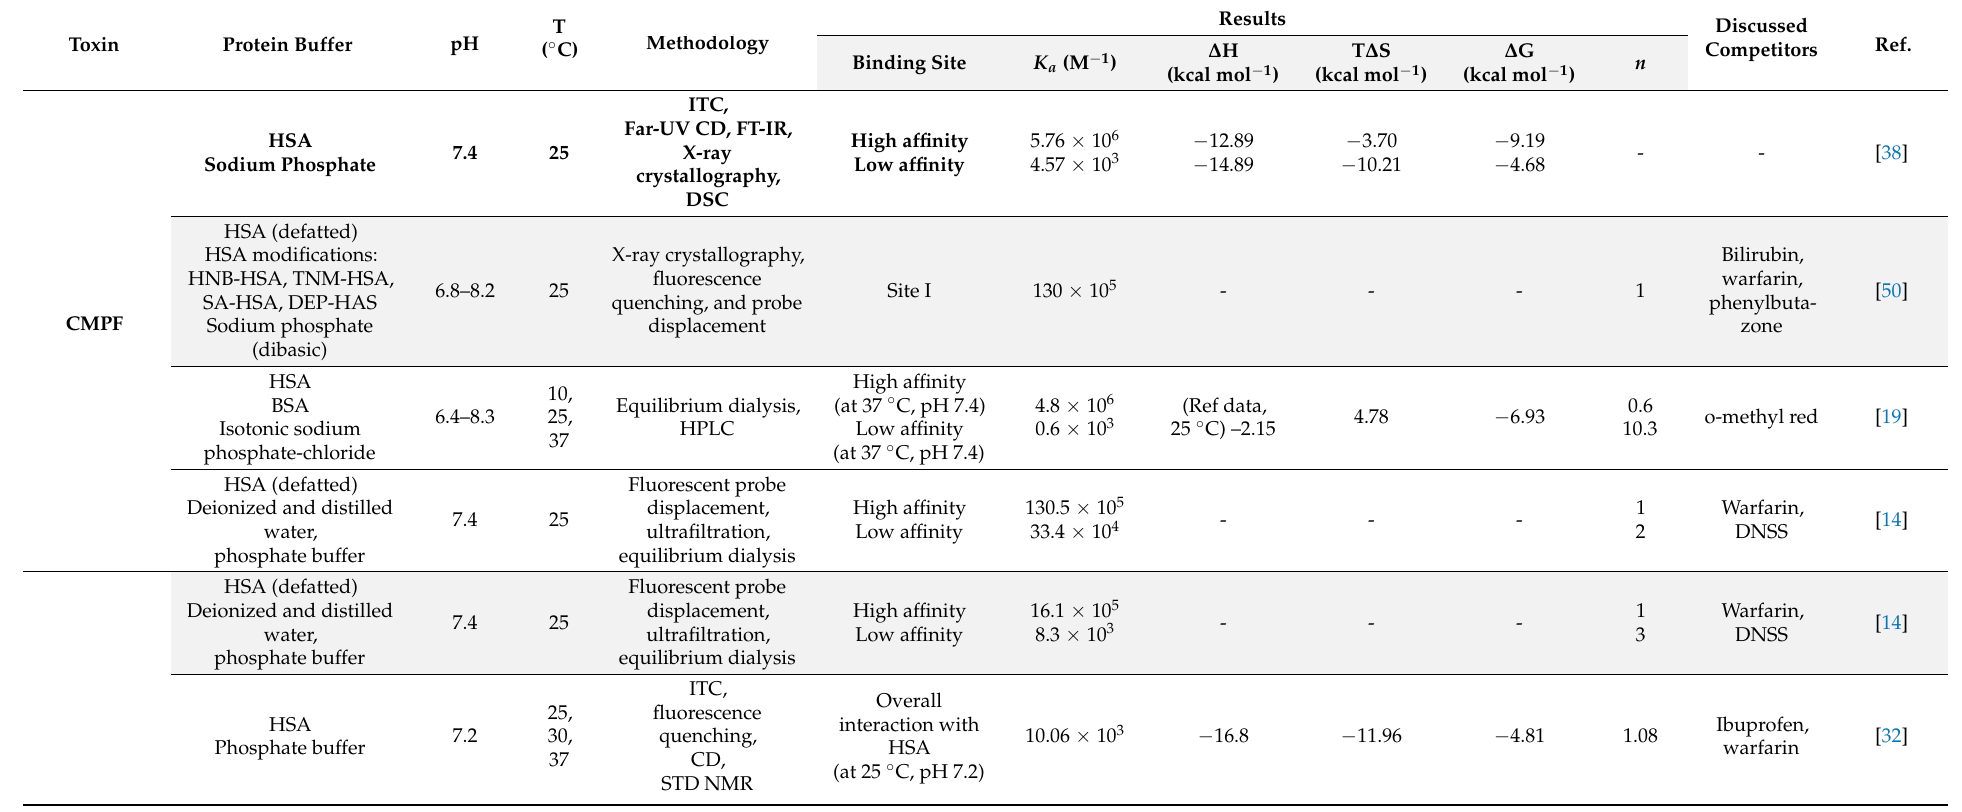
Table 2. Thermodynamic properties of PBUT-HSA binding for CMPF, IS, IAA, HA, PAA, and PCS with sample properties and